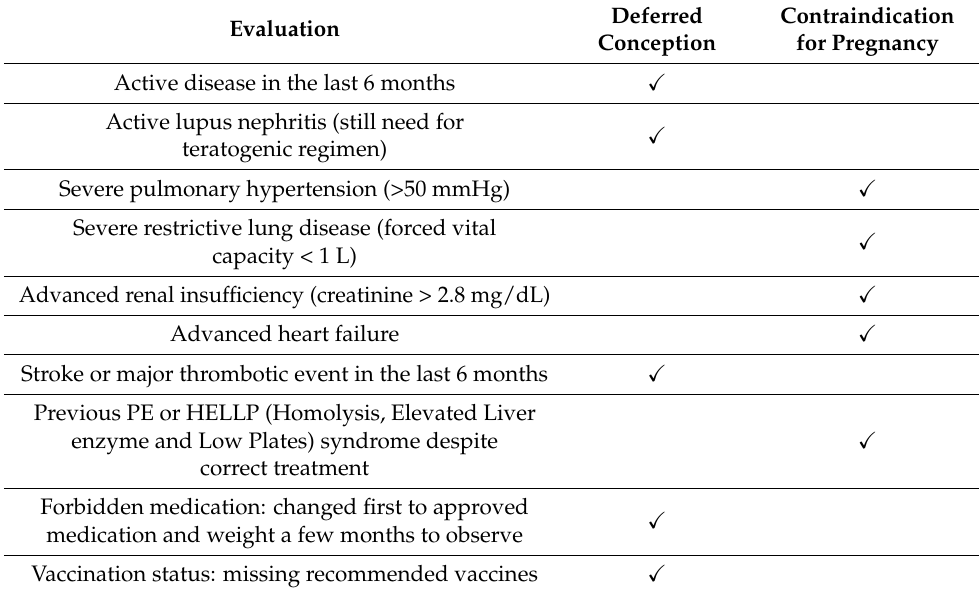
Table 7. Importance of pre-conception evaluation: when to defer or to contraindicate an SLE